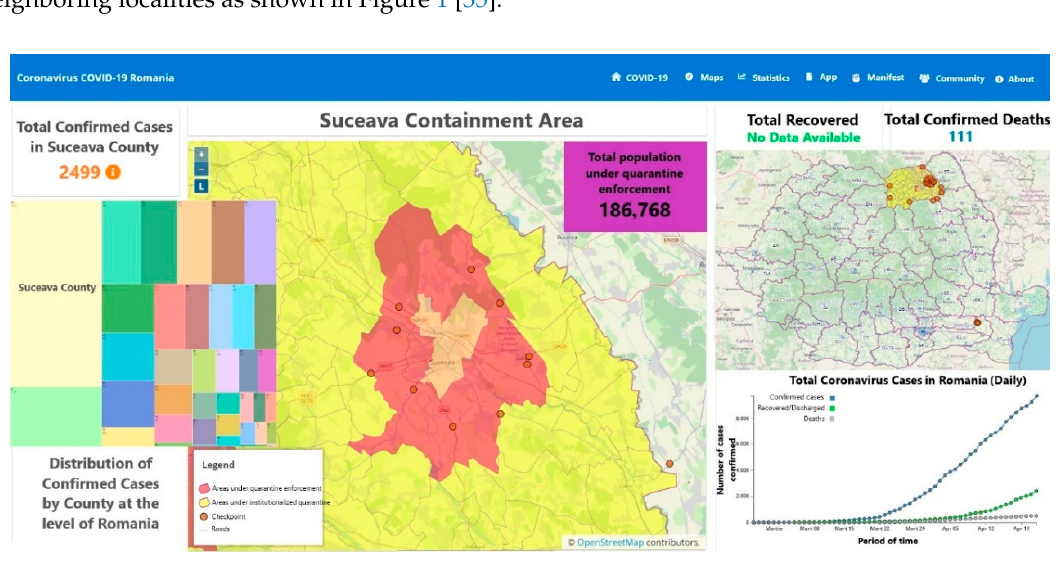
Figure 1. The quarantined area of Suceava. Images processed by authors and reproduced with permission from Geo-spatial.org [36].